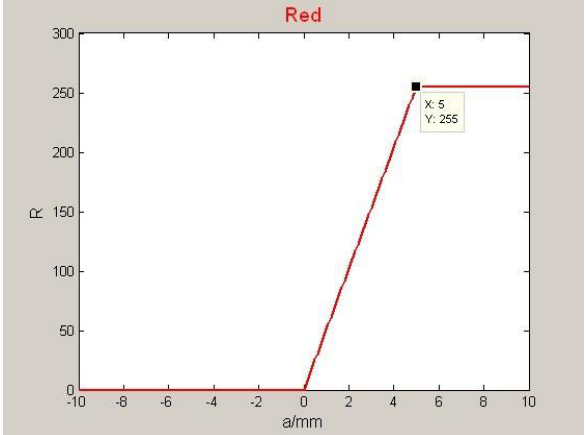
Figure 3. Red colour coding when the deformation velocity ranges from -10mm/y to 10mm/y